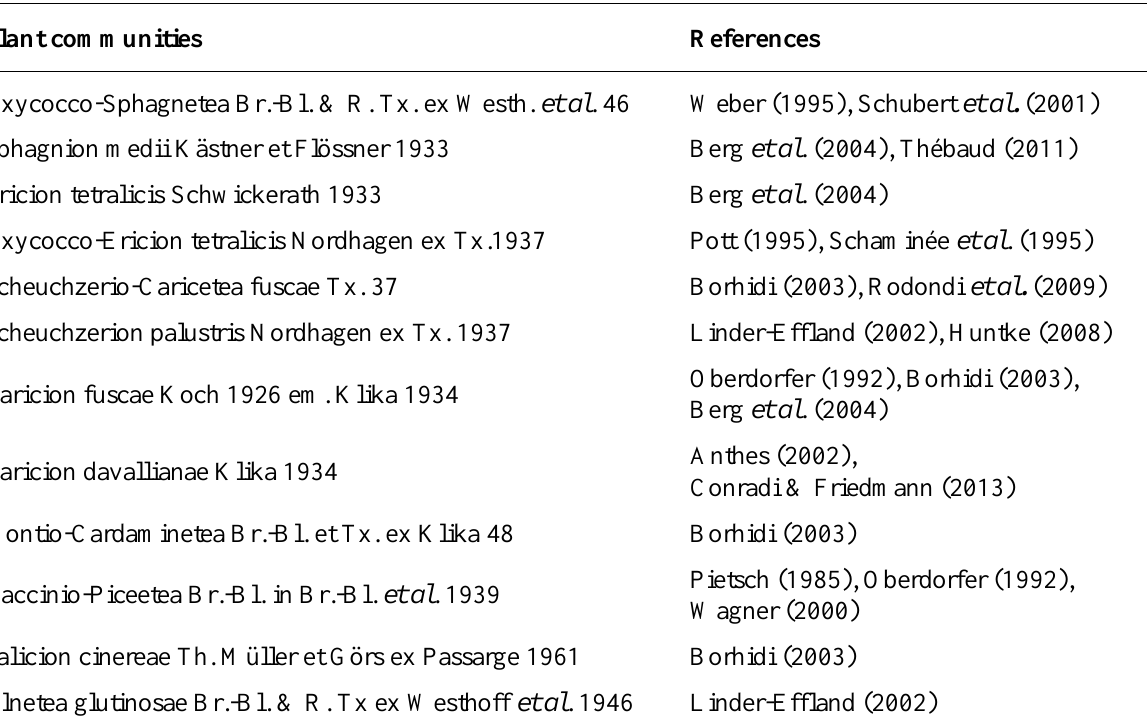
Table 3: List of central European plant communities that include Drosera rotundifolia . Plant